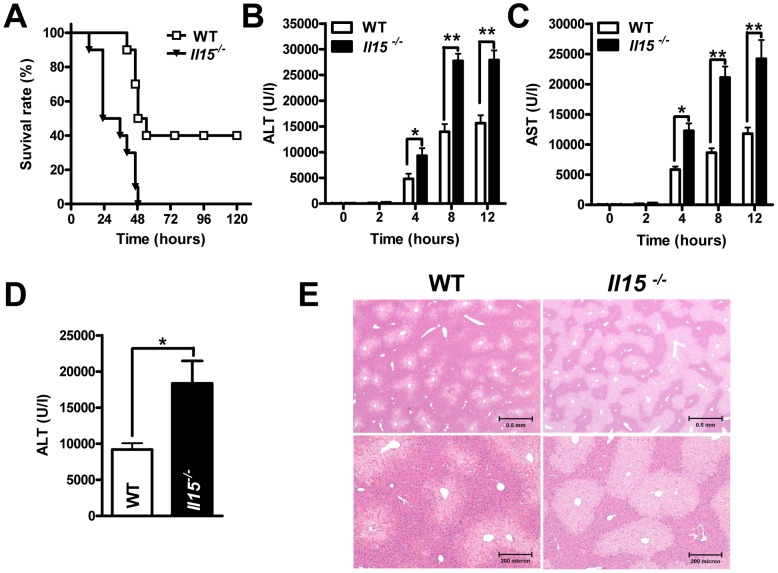
Deficiency of IL-15 exacerbates APAP-induced fulminant hepatitis in mice.(A) Survival of Il15−/− (n = 8) and WT (n = 10) mice for 5 days after APAP injection. P<0.01 for Il15−/− mice compared to WT controls. Serum levels of (B) ALT and (C) AST at indicated times after treatment with APAP. (D) Serum ALT levels and (E) liver histopathological changes at 8 hr after treatment with 200 mg/kg of APAP (H&E staining; magnification, upper panels, ×4; lower panel, ×10). *P<0.05; **P<0.001. Data are mean ± SEM from 5∼8 mice per group.